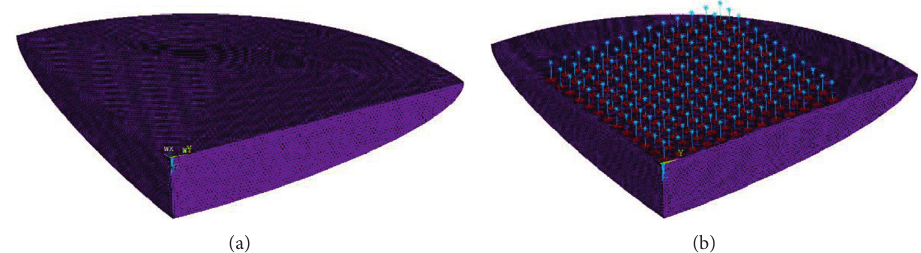
Figure 1: The model of 3D dense building groups-homogeneous sedimentary basin: (a) no building; (b) building groups.